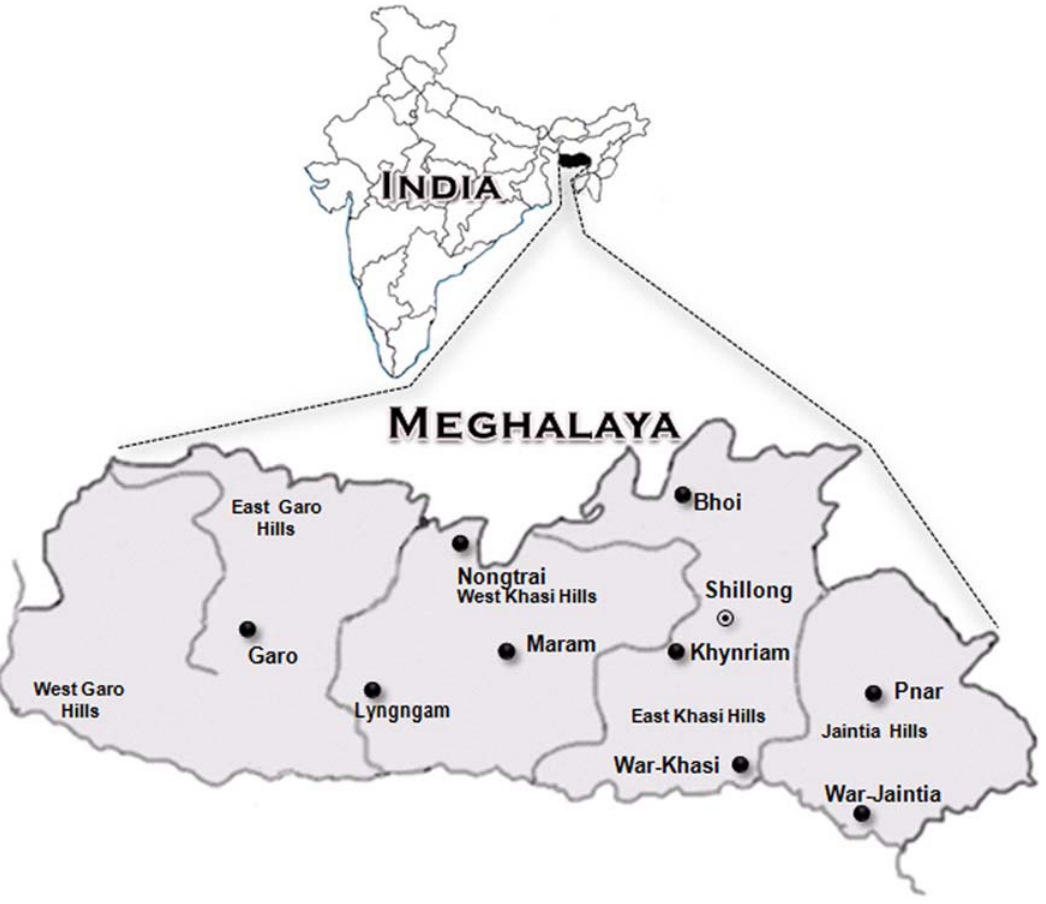
Figure 1. Map of Meghlaya showing the core areas of geographic distribution of the Khasi and Garo populations.